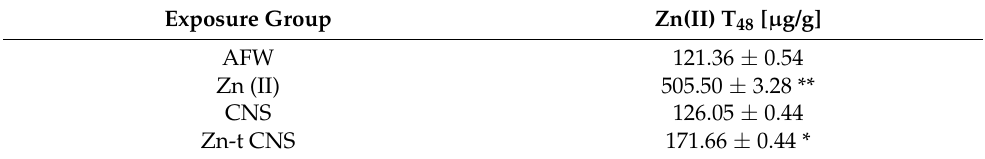
Table 3. Zn concentration ( µ g/g dry weight) in zebra mussels’ whole soft tissue after 48 h (T 48 ) of exposure as follows: AFW (control); Zn(II) 50 mg/L in AFW; Zn-t CNS (Zn(II) 50 mg/L contaminated AFW treated with CNS, CNS (AFW treated with CNS only). Data are reported as mean ± SD. * p < 0.05; ** p < 0.01 in respect to the controls (ASW). Exposure Group